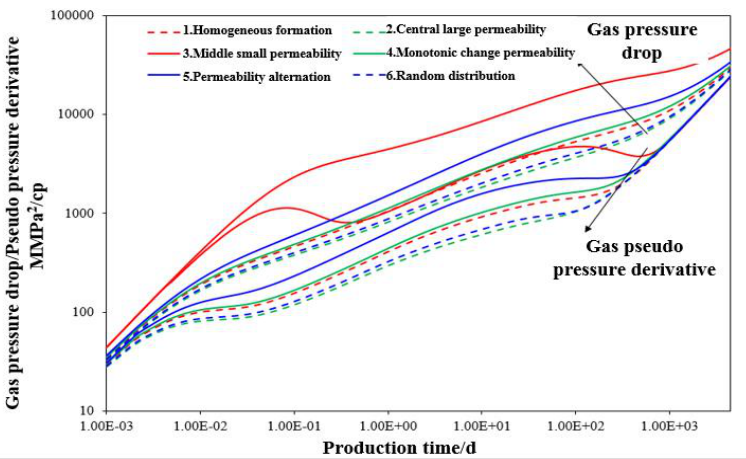
Figure 4—Reservoir permeability distribution.